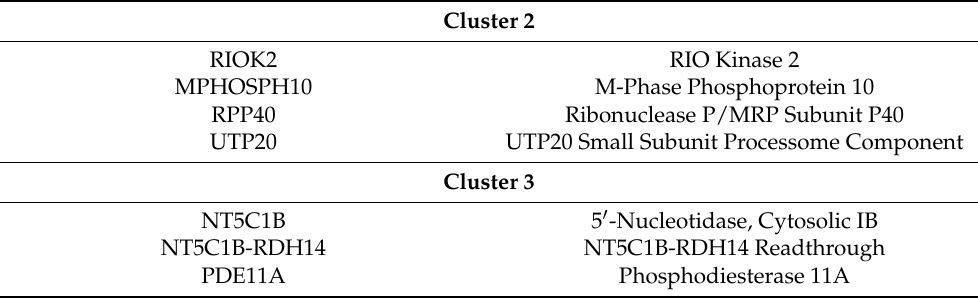
Figure 5. Cluster 1 of the PPI network identified according to MCODE. The cluster consists of 6 nodes and 12 edges. Table 5. Clusters identified in the PPI network according to MCODE and their description based on Genecards.